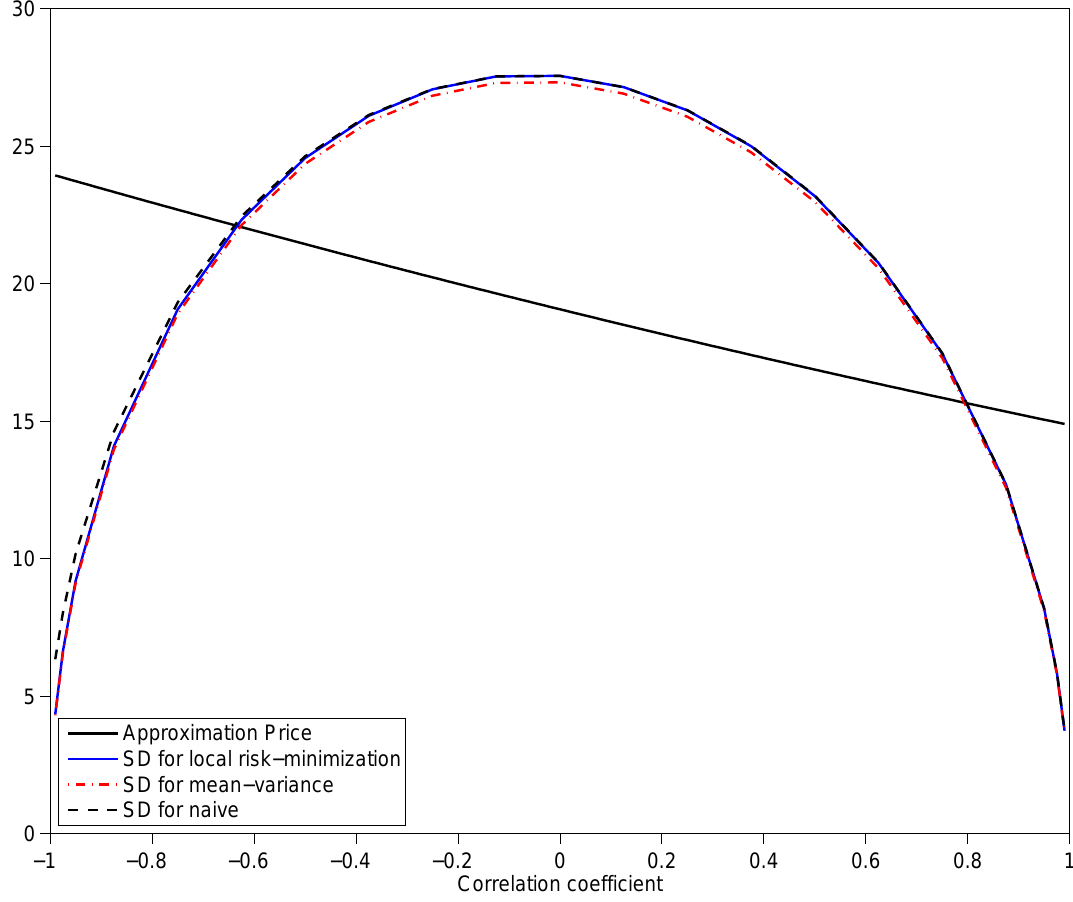
Figure 3. Approximation price and standard deviation of hedging error vs. correlation, for the call option with parameters given by Table